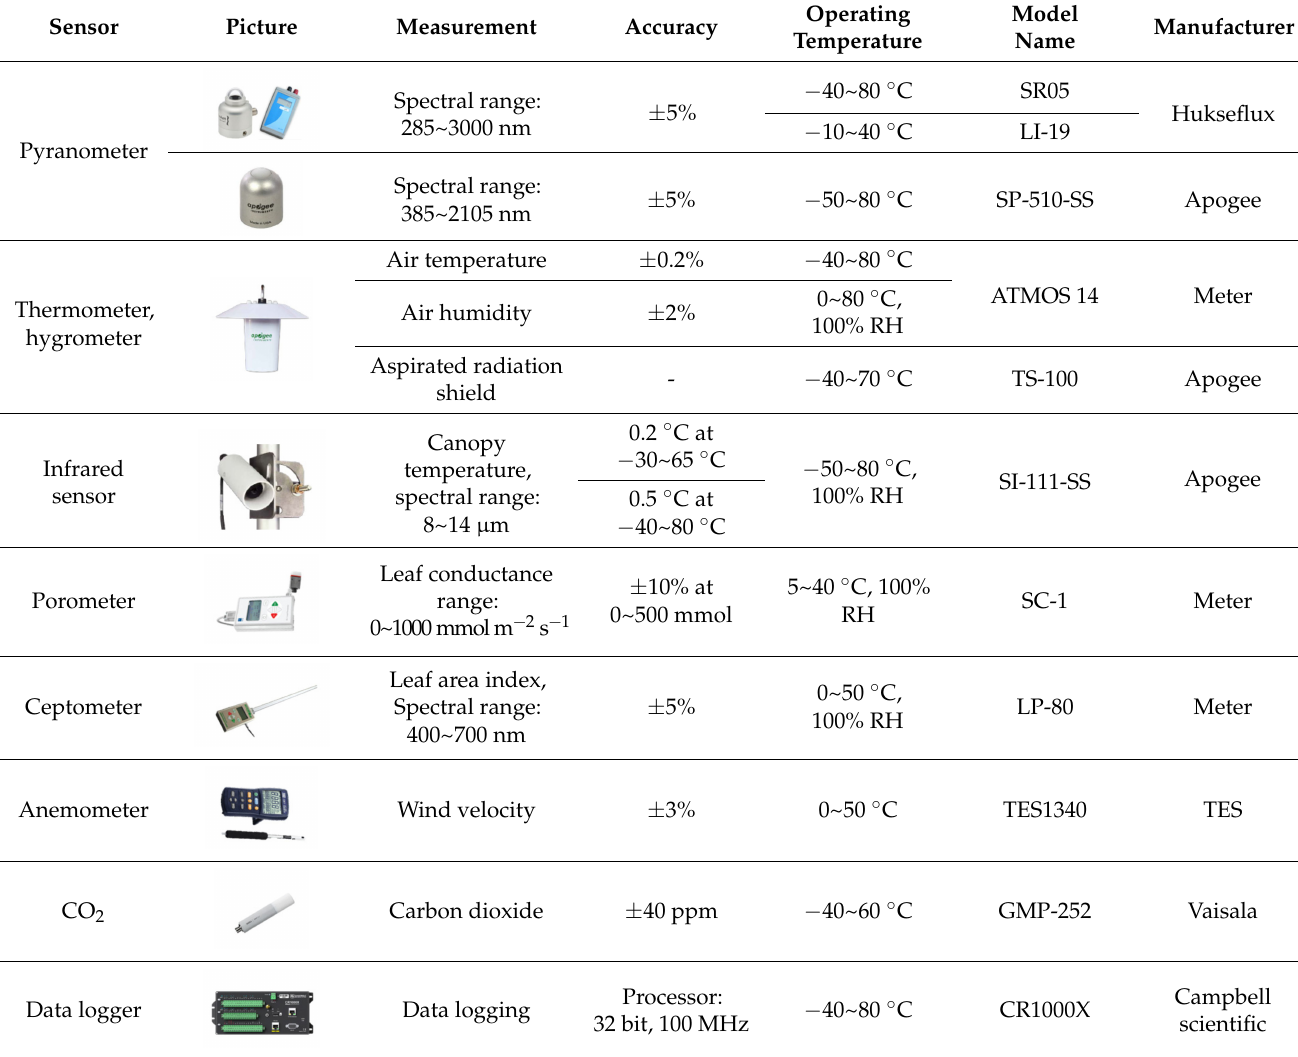
Table 2. Specification of sensors used in this study.